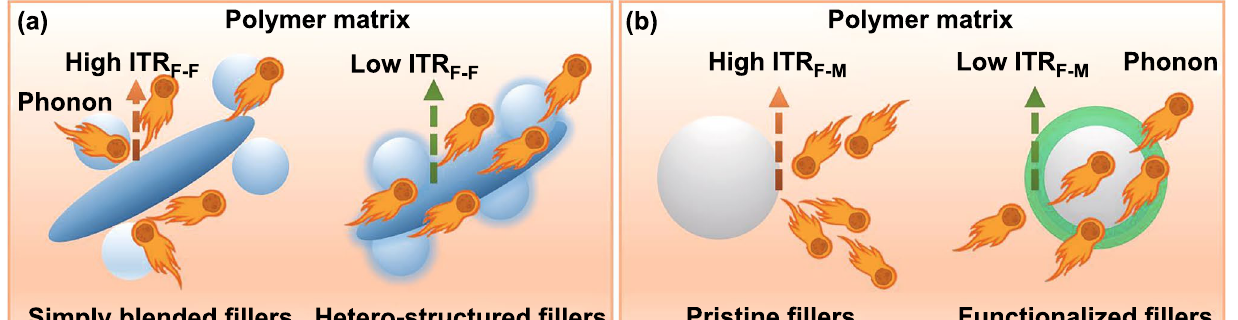
Fig. 2 Schematic diagram of ITR F-F ( a ) and ITR F-M ( b